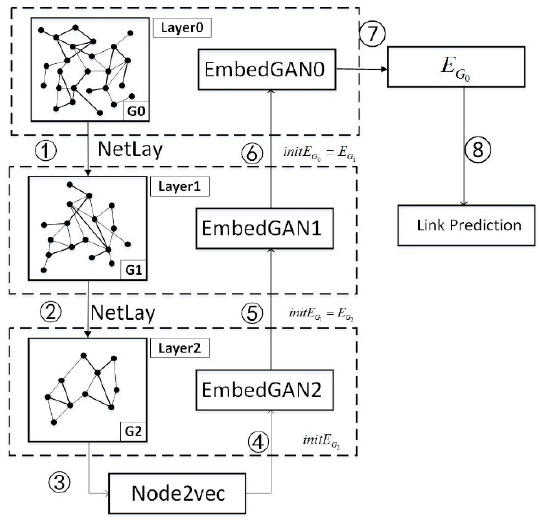
Figure 1. Framework of the proposed algorithm.